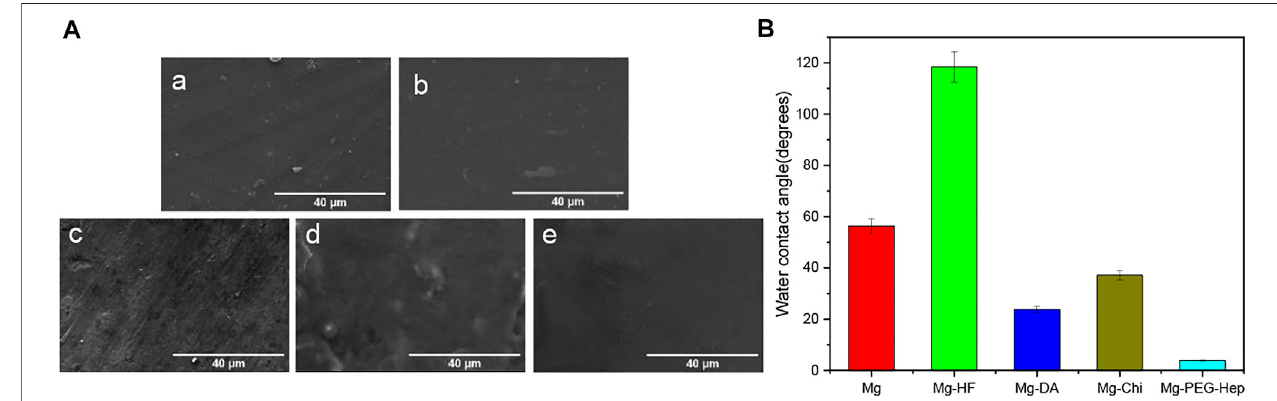
FIGURE 3 | (A) SEM images of (a) Mg, (b) Mg-HF, (c) Mg-DA, (d) Mg-Chi, (e) Mg-PEG-Hep, (B) The water contact angles of the different